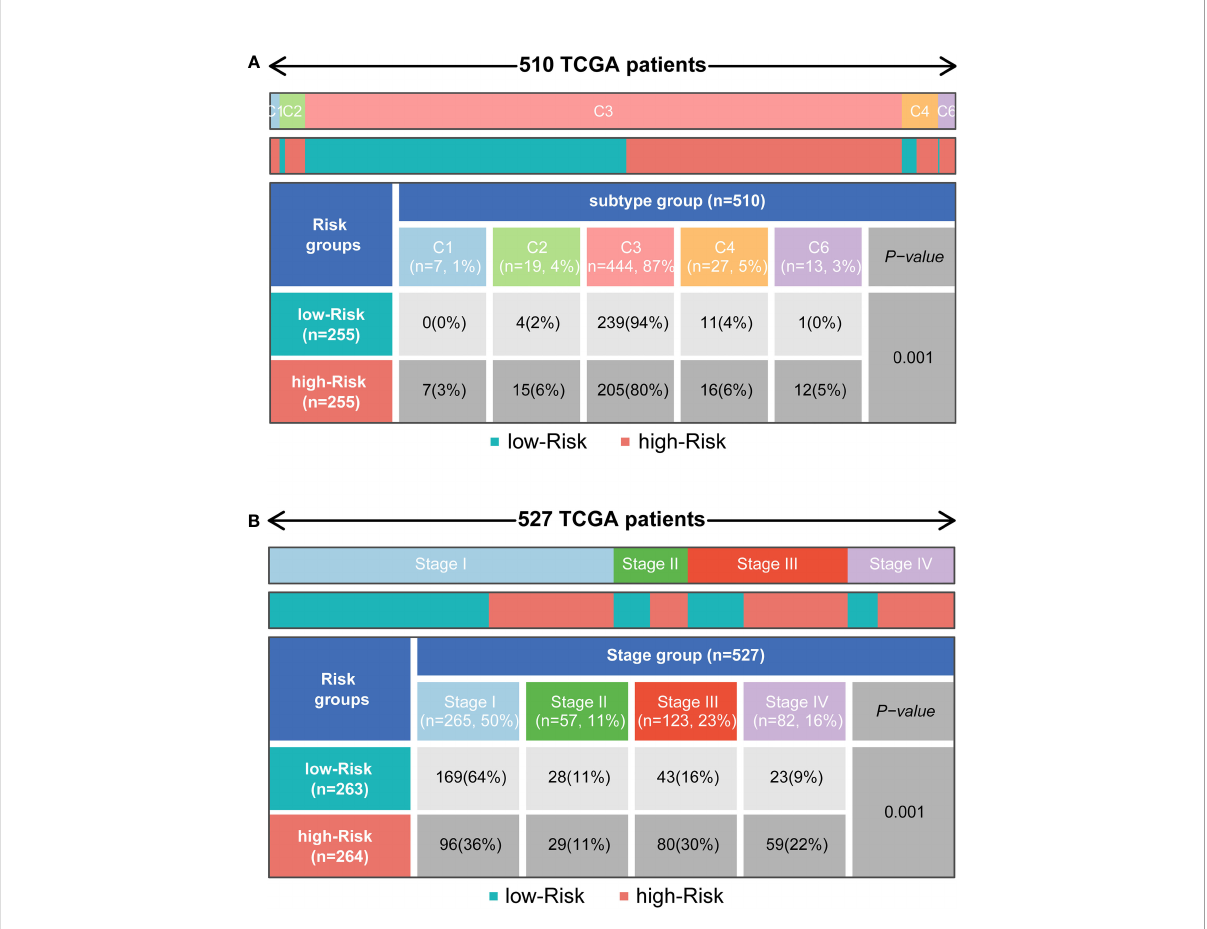
FIGURE 6 Distribution of immune subtypes and the clinicopathologic characteristics in different subgroups. (A) Heatmap and table showing the distribution of tumour immune subtypes (C1, C2, C3, C4, C5, C6) between subgroups. (B) Heatmap and table showing the distribution of clinicopathologic characteristics between